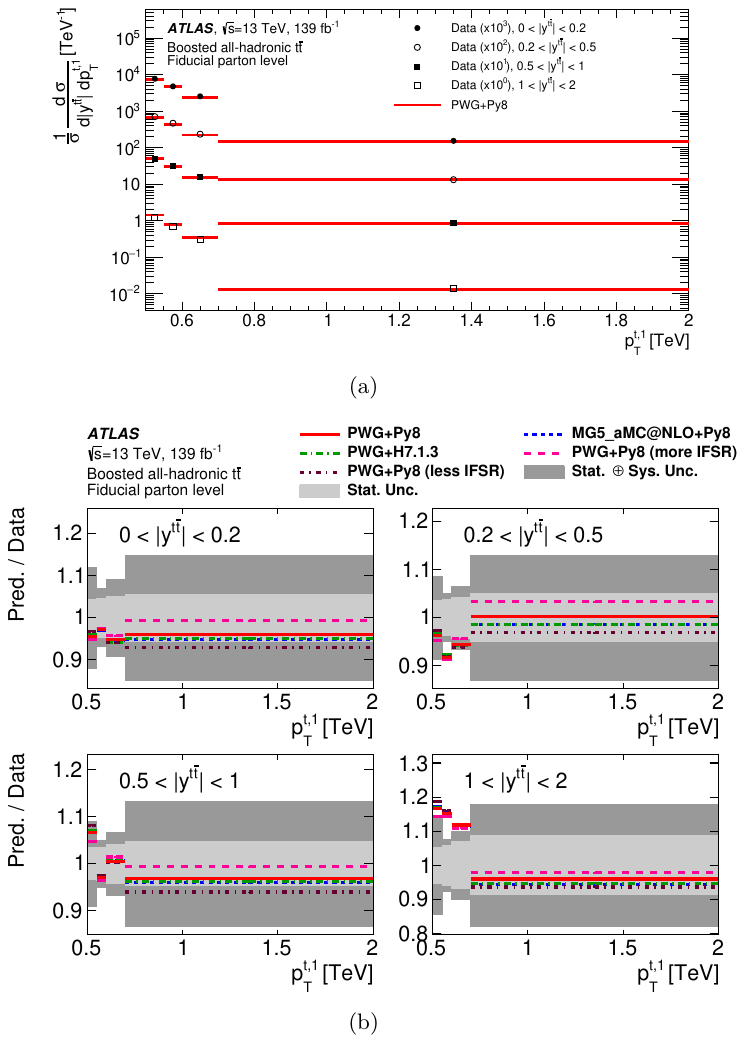
Figure 48 . (a) Normalized parton-level fiducial phase-space double-differential cross-sections as a function of the absolute value of the rapidity of the t ¯ t system and the transverse momentum of the leading top quark, compared with the Powheg+Pythia 8 calculation. Data points are placed at the centre of each bin and the Powheg+Pythia 8 calculation is indicated by solid lines. The measurement and the prediction are normalized by the factors shown in parentheses to aid visibility. (b) The ratios of various MC calculations to the normalized parton-level fiducial phase- space differential cross-sections. The dark and light grey bands indicate the total uncertainty and the statistical uncertainty, respectively, of the data in each